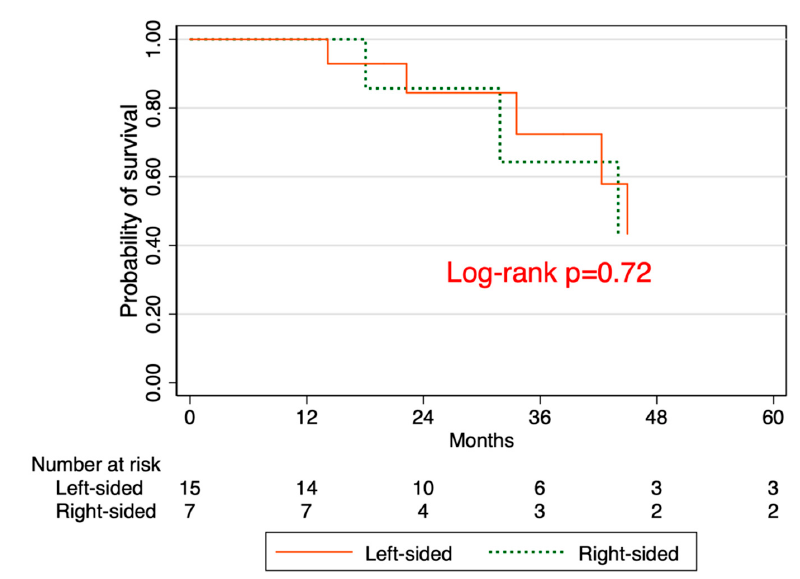
Figure 2. Kaplan–Meier survival based on tumor location.